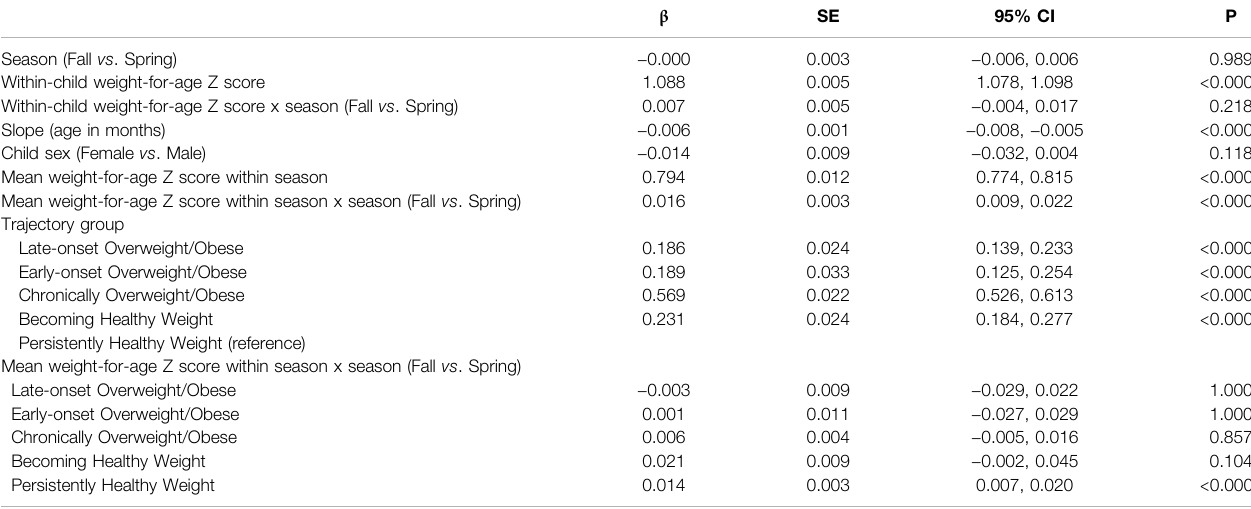
TABLE 4 | Mixed model fi ndings testing the association of weight-for-age Z scores with the outcome of BMIz. β SE 95% CI P Season (Fall vs . Spring) − 0.000 0.003